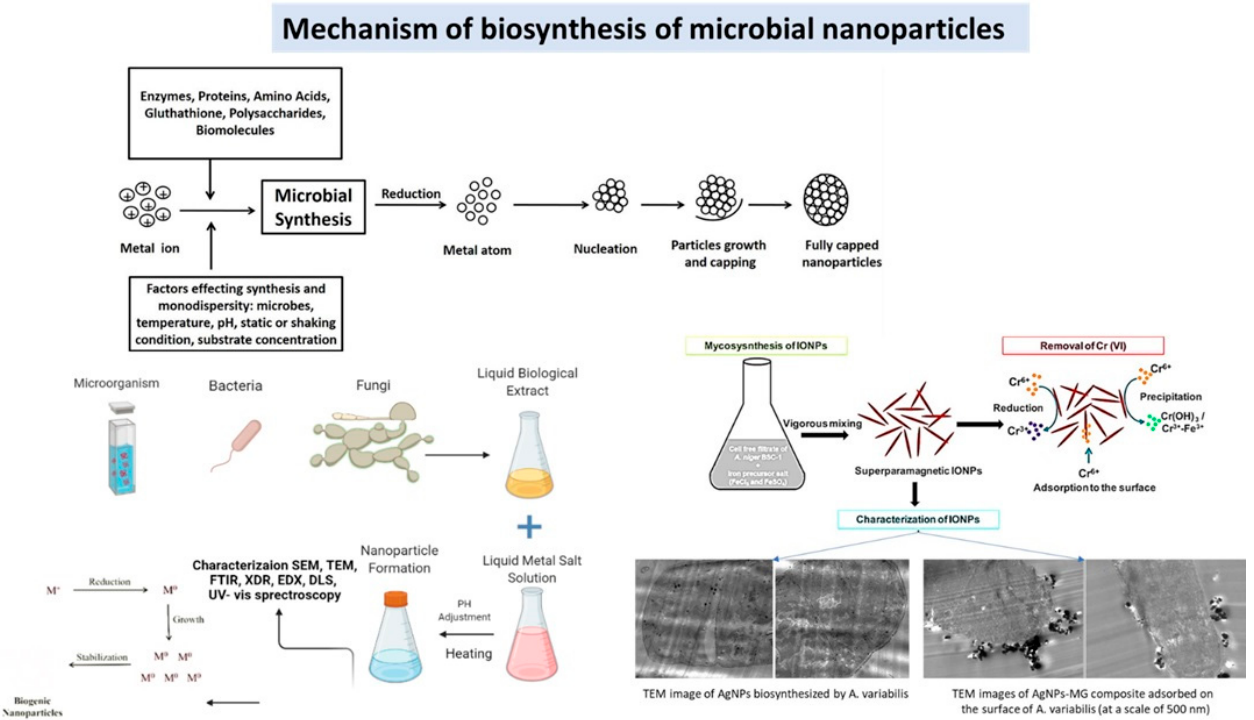
Figure 2. Mechanism of biosynthesis of microbial nanoparticles and their analysis for treatment [39]. Reprinted/adapted with permission from Ref. [39]. NPs are synthesized using metabolites and cell components of microbial cells, includ- ing bacteria, fungi, actinomycetes, and microalgae, by activating or stimulating intracellular or extracellular pathways and used in wastewater treatment [42]. Fungus like Aspergillus tubingensis , Avicennia officinalis , Chlorella vulgaris are already used in the synthesis of iron NPs. The microbial cell enzymatic machinery reduced the entrapped metal ions and macromolecules accumulated on the cell surface or intracellular regions into NPs [43].